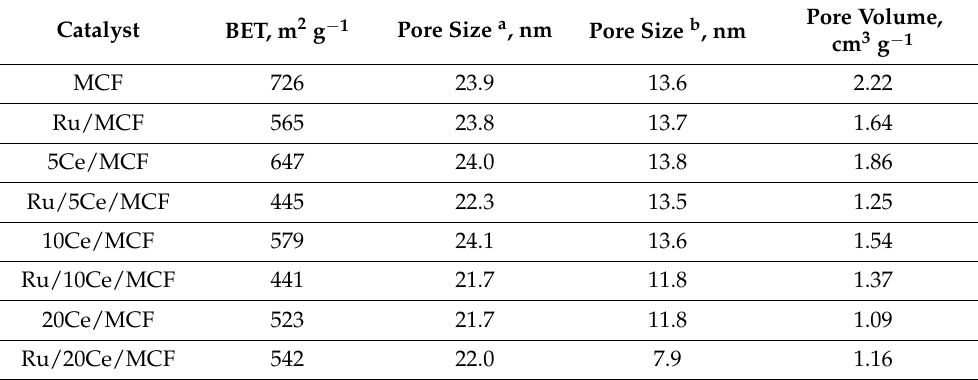
Textural parameters of the catalysts extracted from low temperature nitrogen physisorption